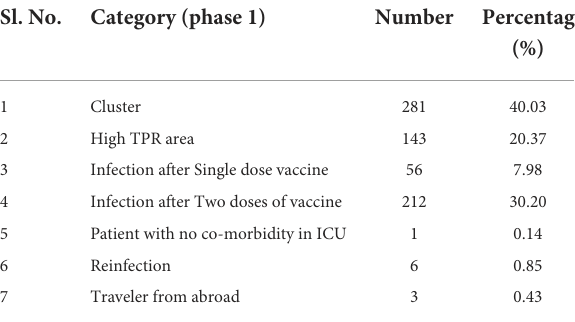
TABLE 2 Details of samples collected during phase 1 (March 2021 to October 2021) which met the inclusion criteria. Sl.